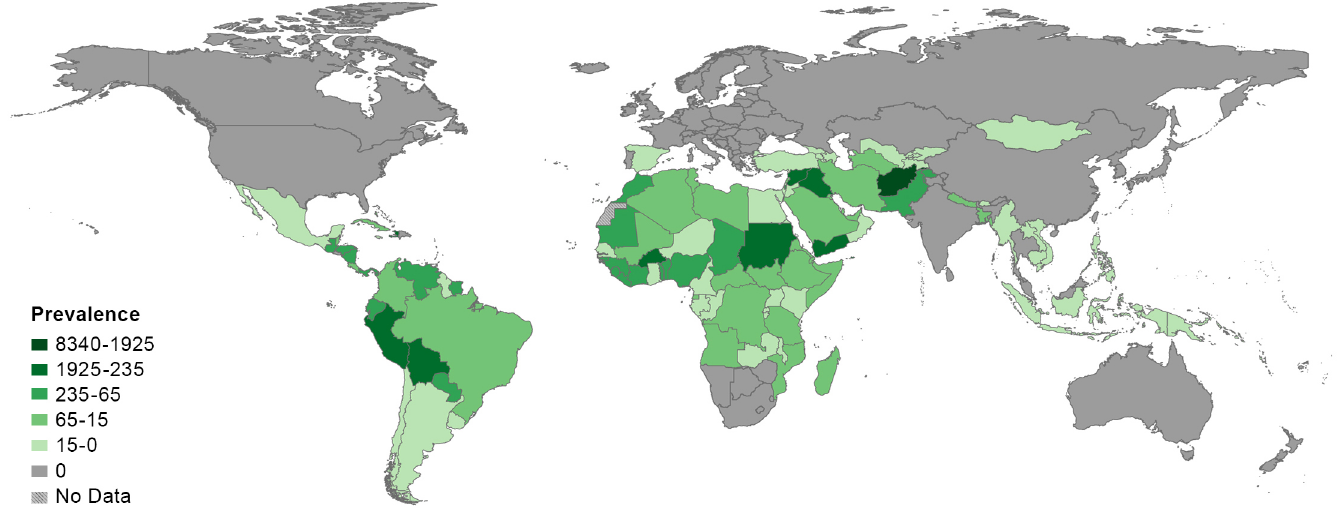
Fig 2. Global cutaneous/mucocutaneous leishmaniasis prevalenceper 100,000population in 2013. NOTE: No estimates are available for Western Sahara as it was not a modeledlocationin the Global Burden of Disease Study (GBD) 2013.